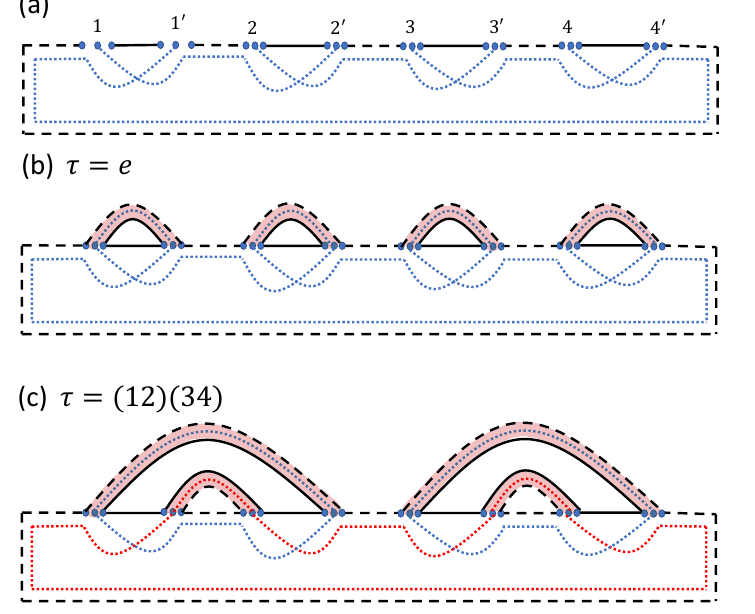
Figure 2 . (a) shows the common lines of all diagrams for different terms in (3.4), and (b) and (c) show examples for two choices of τ , for the case n = 4 . The dotted loops are shown in two different colors in (c) to make the distinction between different loops clear.